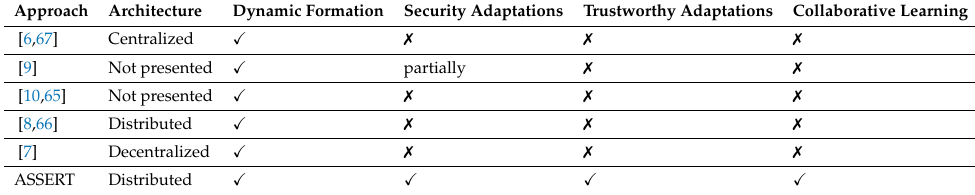
Table 2. A comparison with existing approaches proposed to engineer goal-driven and self-adaptive (IoT)